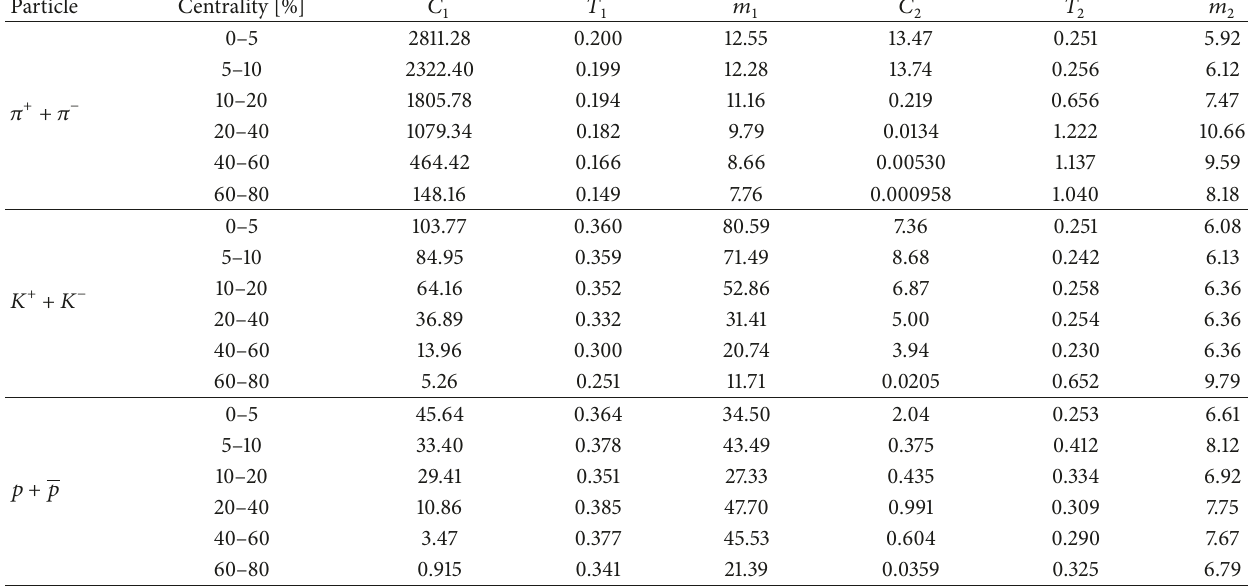
Table 1: The fitting parameters for various particles with double-Tsallis distribution (3).